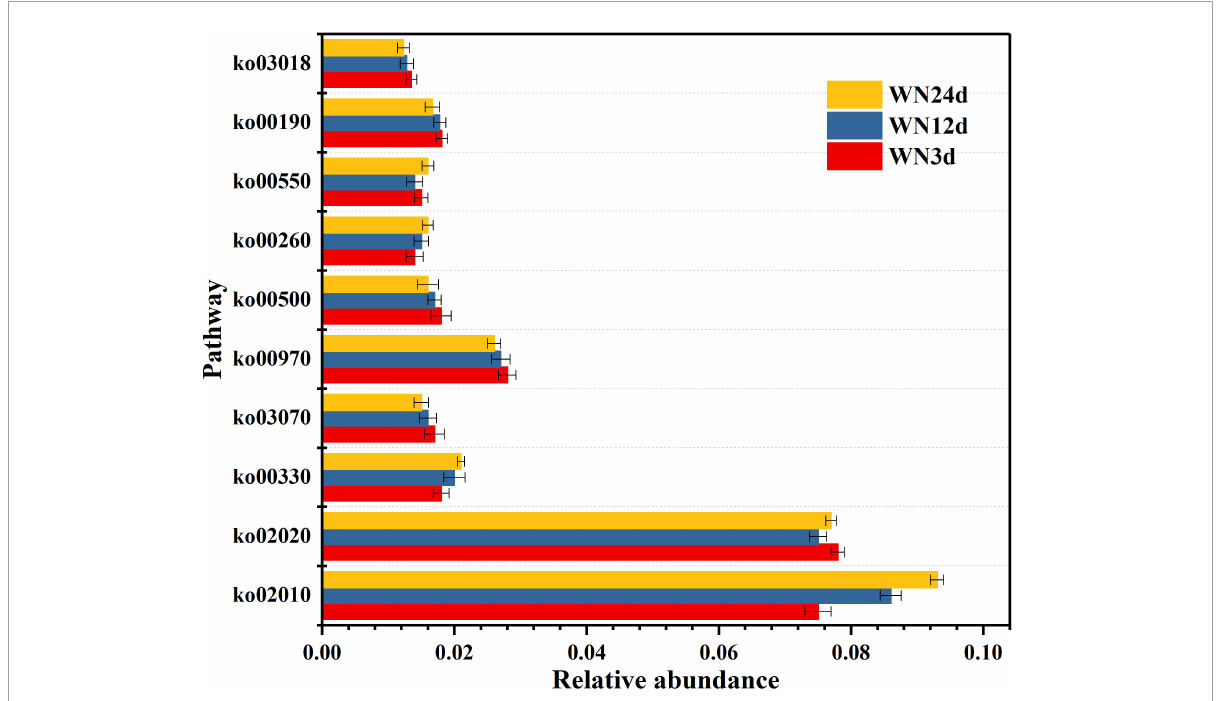
FIGURE6 Comparison of differences in abundance of metabolic pathway genes during the composting process (the top 10 metabolic pathways with the largest abundance